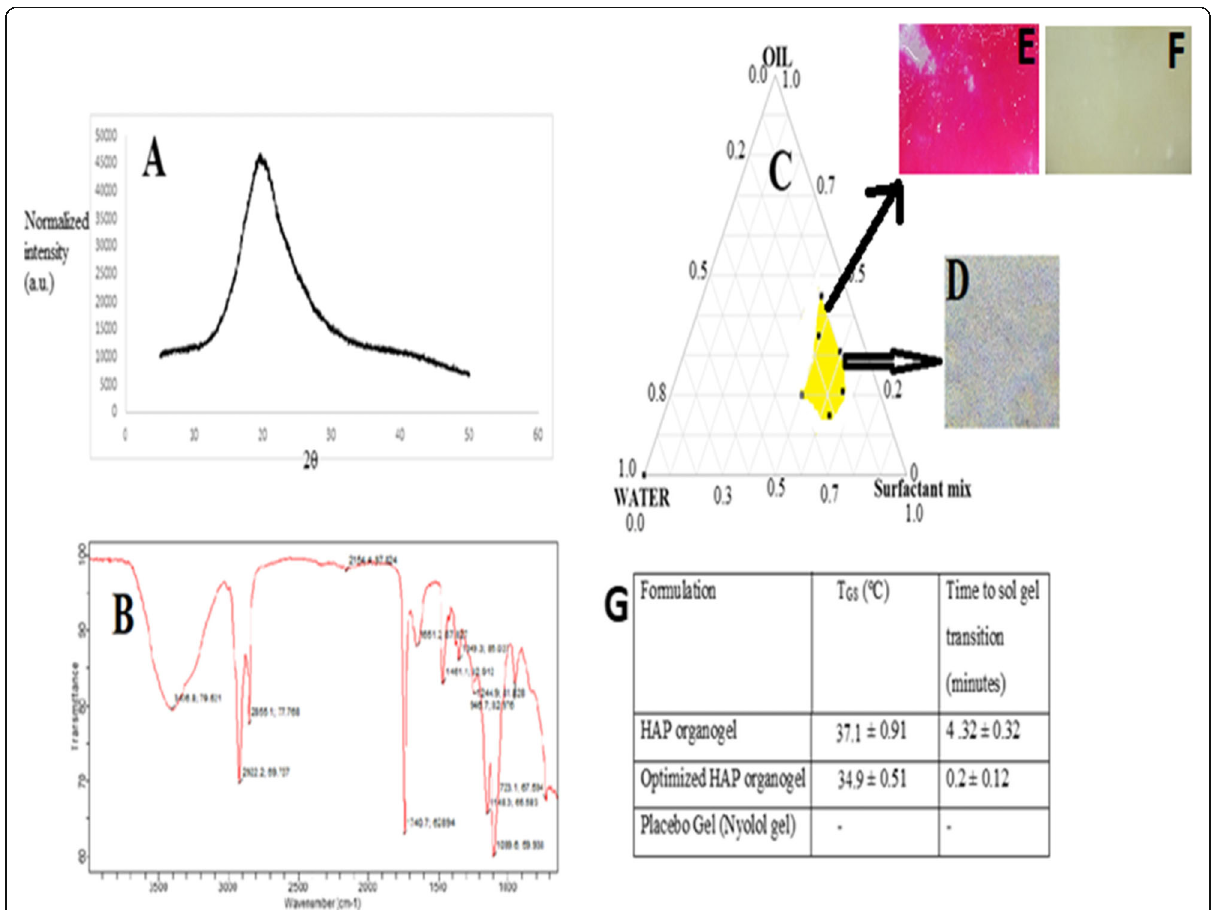
Fig. 3 Showing a X-ray diffractogram, b FTIR spectra, c pseudo ternary phase diagram, and d micrograph at × 80 magnification of the optimized hyaluronic acid-palm oil HAP-based organogel. e Optimized hyaluronic acid-palm oil HAP organogels prepared with aqueous rhodamine B solution. f Optimized hyaluronic acid-palm oil HAP organogel formulation. g Gel to sol transition temperature T GS (°C) obtained using falling ball method of the optimized hyaluronic acid-palm oil HAP